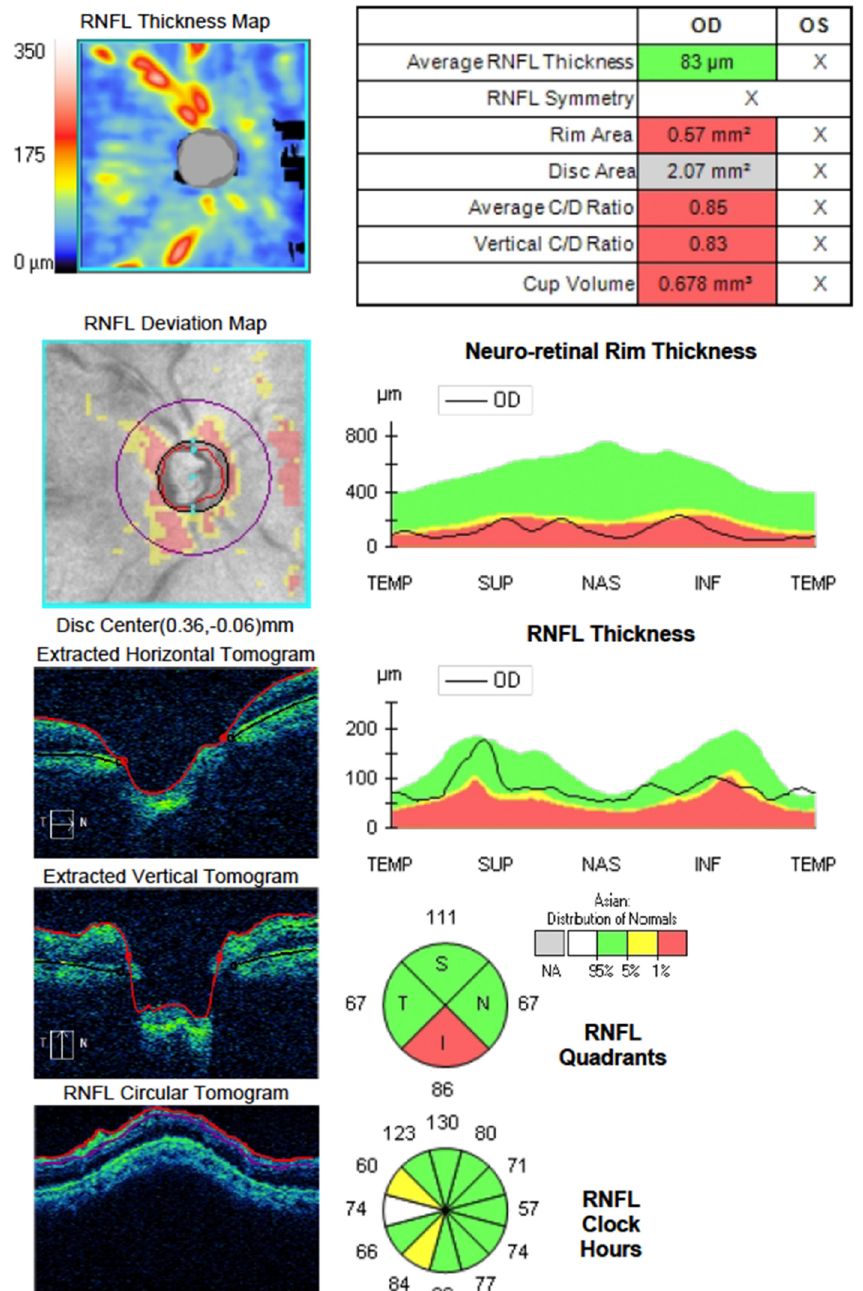
Figure 1: Preoperative optical coherence tomography of the optic nerve head showing cupping and thinning of the neuroretinal rim at its inferior aspect